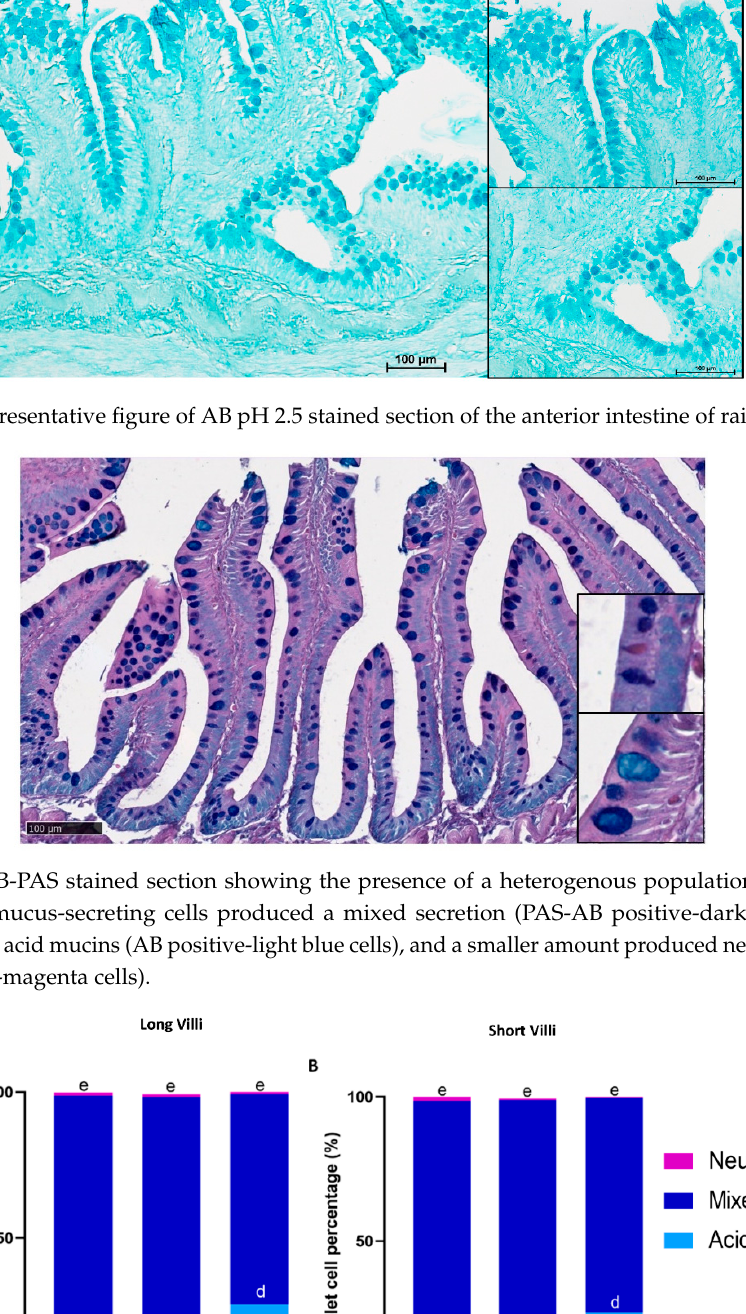
Figure 9. Representative figure of AB pH 2.5 stained section of the anterior intestine of rainbow trout.